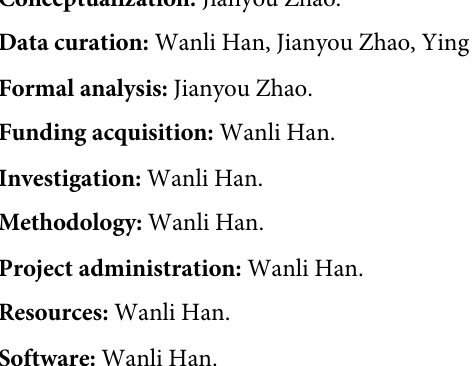
S1 Table. Driver Behavior Questionnaire